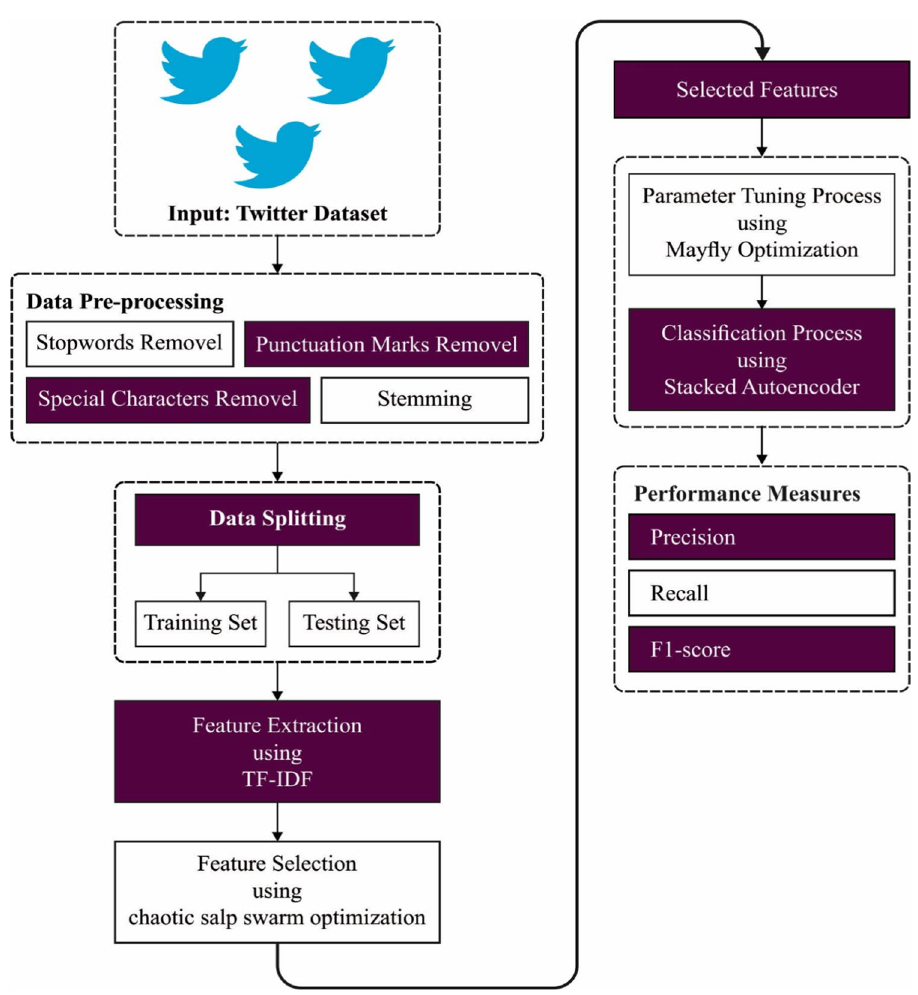
Fig. 2 Overall process of AICBF-ONS